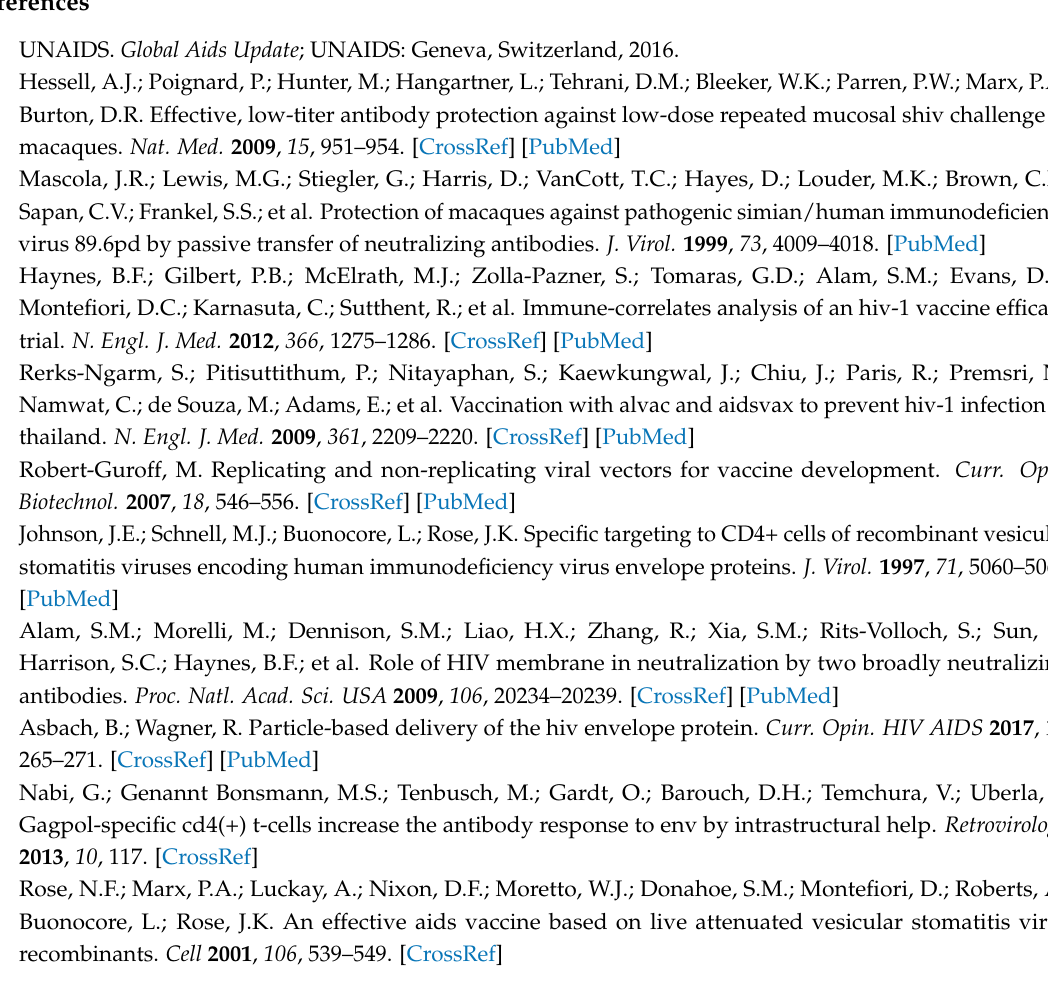
Supplementary Table S1. Statistical analysis for Figure 2E, Supplementary Table S2. Statistical analysis for Figure 5, Supplementary Table S3. VSV-GP-env induces Tier 1A but no Tier 2 neutralizing antibodies upon immunization of rabbits, Supplementary Figure S1. VSV-GP particles containing HIV env show a high glycoprotein density on the